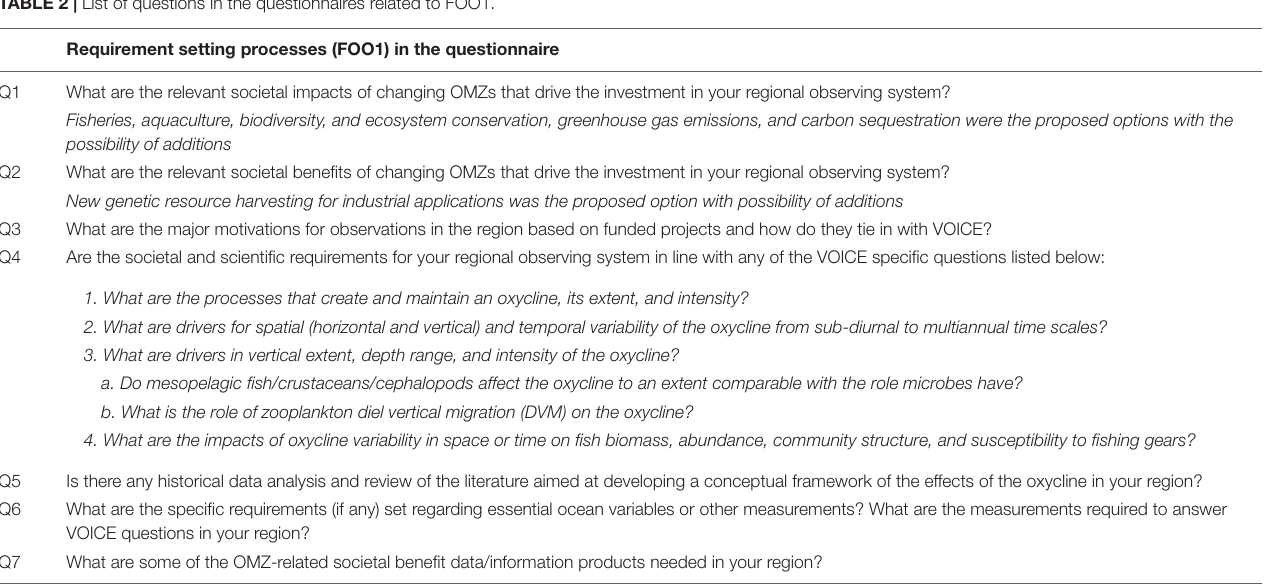
TABLE 2 | List of questions in the questionnaires related to